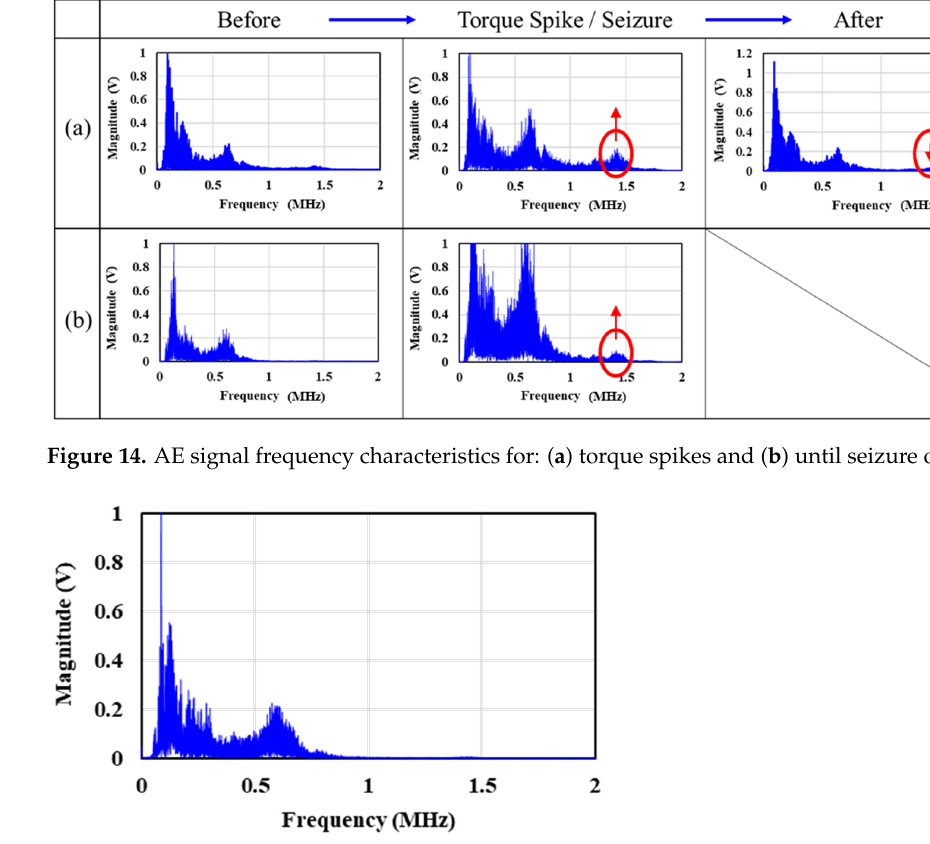
Figure 15. AE signal characteristics for a-C:H:Si-coated journal at load of 99 kN (181 MPa).